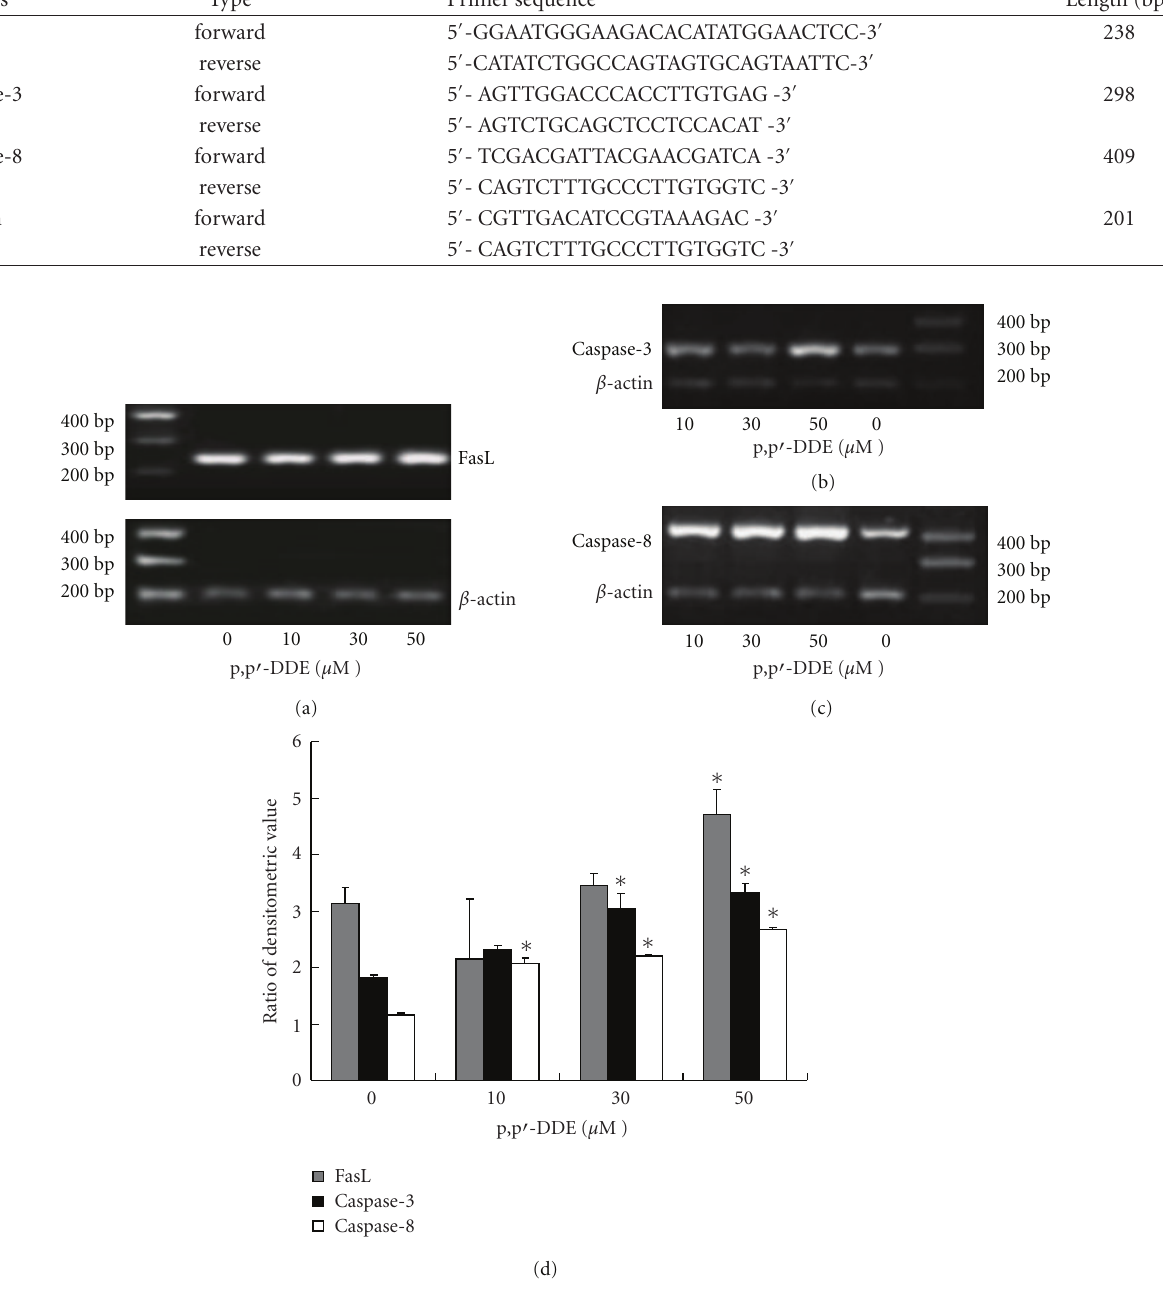
Figure 4: E ff ects of di ff erent p,p (cid:2) -DDE concentrations on the FasL and caspase-3 and -8 mRNA in rat Sertoli cells by RT-PCR (a)–(c). Quantitative analysis of FasL and caspase-3 and -8 mRNA levels of rat Sertoli cells exposed to di ff erent doses of p,p (cid:2) -DDE (d). The data were obtained from the bands on the gels that were measured by densitometric analysis and standardized by comparison to the β -actin control using Biocapt MV software analysis system. Significant di ff erence is ( ∗ ) P < . 05, compared with the control